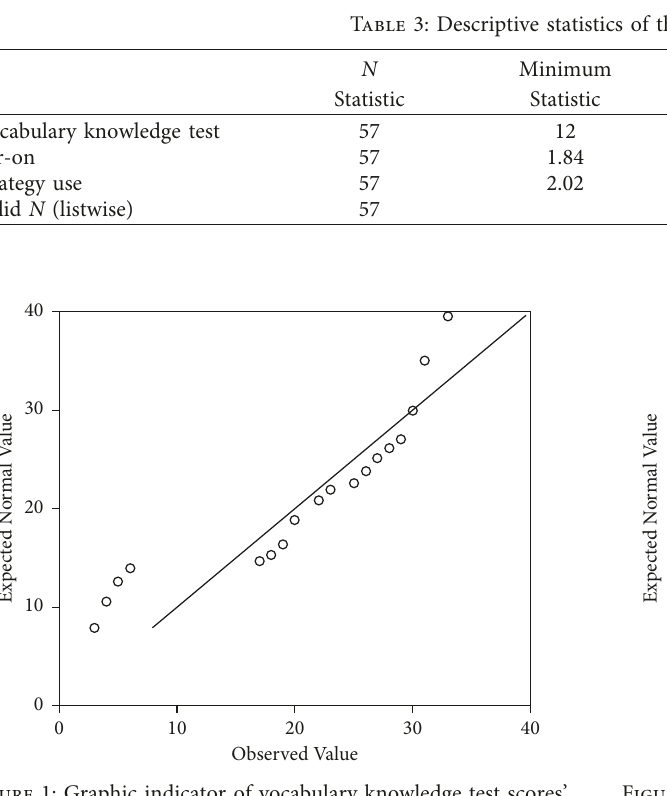
Figure 1: Graphic indicator of vocabulary knowledge test scores’ normality.